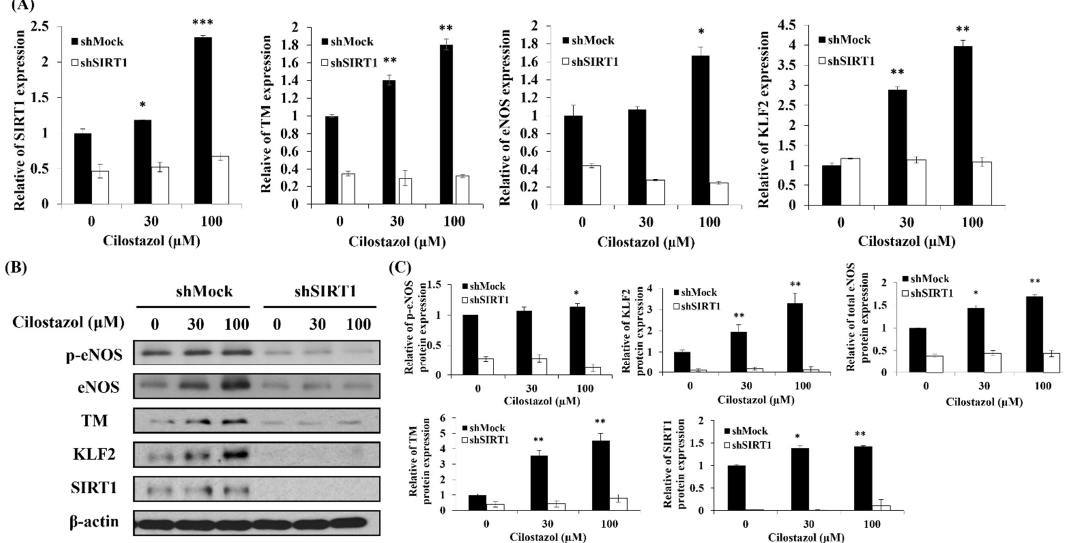
Figure 6. SIRT1 as a regulator of KLF2 in the cilostazol-treated HUVECs. HUVECs, shMock, or shSIRT1 were cultured with 0, 30, and 100 μM cilostazol. After 24 h, the cells were collected. The SIRT1 mRNA expression was identified using either ( A ) quantitative real-time PCR or ( B ) the protein expression was determined using Western blot. ( C ) Reflective densitometry of Western blot. Data are expressed as mean ± SEM, n = 3. * p < 0.05, ** p < 0.01 and *** p < 0.001 compared to the untreated group [27].